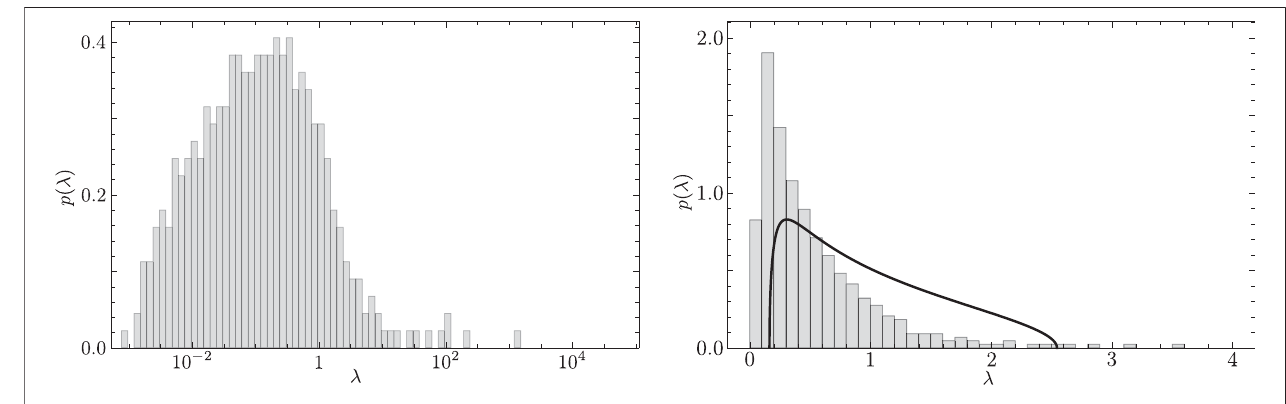
FIGURE 2 | (Left) Distribution p ( λ ) of eigenvalues λ of the empirical equal-time cross-correlation matrix. (Right) Empirically obtained distribution p ( λ ) of eigenvalues λ in the range of small eigenvalues. The solid line is the Mar ˇ cenko-Pastur distribution under RMT as the theoretical curve given by Eq. 5 .